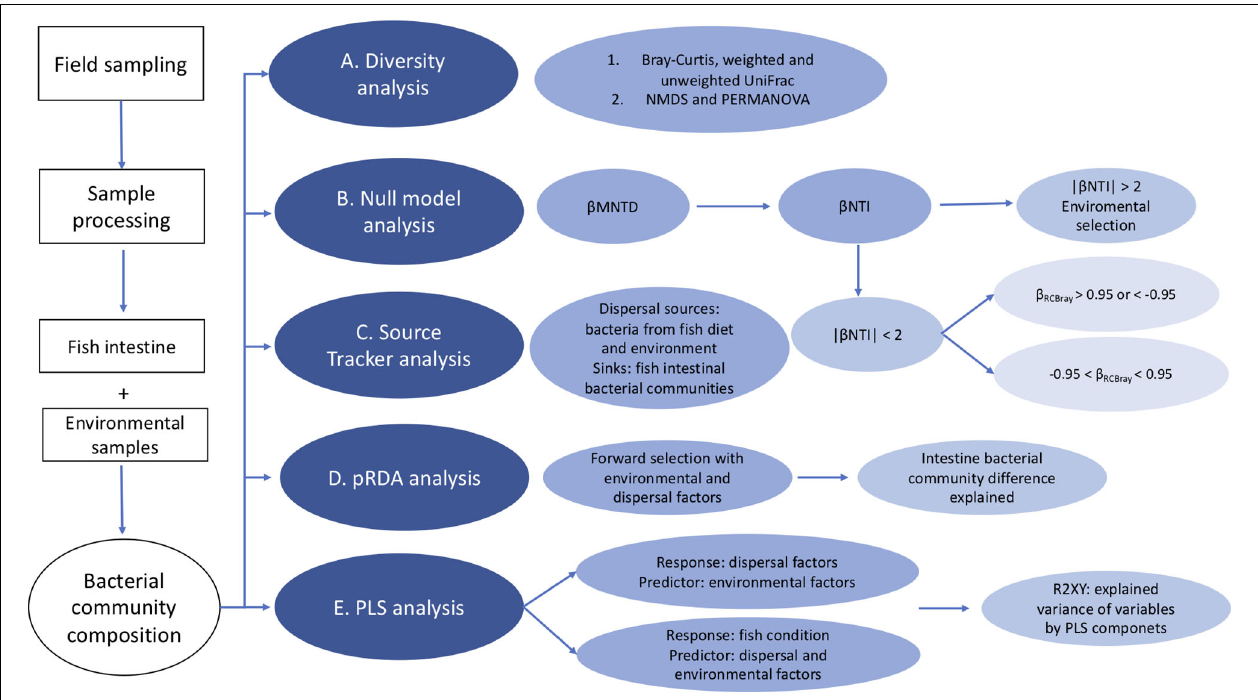
FIGURE 1 | Flow chart of the statistical analysis of this study. (A) Beta diversity analysis of the bacterial community composition using Bray-Curtis and weighted UniFrac distances based on the OTU’s relative abundance. (B) We used null model analysis to determine the contributions of environmental selection and other ecological processes to the assembly of fish intestinal bacterial communities. In this analysis, β MNTD was used to measure the dissimilarities of bacterial communities between fish. Then β NTI is calculated as how much observed β MNTD deviated from the mean of the null distribution based on 1000 randomly shuffling of the tip labels on the phylogenetic tree, to check if the difference between microbial communities is determined by environmental selection when | β NTI | > 2 or not when | β NTI | < 2. For communities with | β NTI | < 2, Raup-Crick distances were calculated based on the relative abundance data. Then we combined β NTI and RC bray into β RCBray , to further assess the contribution of ecological processes. When β RCBray > 0.95 or < –0.95, it indicates that the community variation is influenced by dispersal limitation or mass effects, respectively, when β RCBray is between –0.95 and +0.95, it suggests that community variation is determined by ecological drift. (C) We used Source Tracker analysis, which is a Bayesian method to estimate the proportion of one community that originates from a set of source environments (Knights et al., 2011). In our study, we used it to determine the contribution and relative importance of different dispersal sources to intestinal bacterial communities. (D) pRDA analysis with forward selection is used to test how much the significant variables could explain the differences among fish intestinal bacterial communities. (E) PLS analysis is used to predict the relationship between dispersal factors and environmental factors on one hand, and fish body condition on the other with both environmental and dispersal